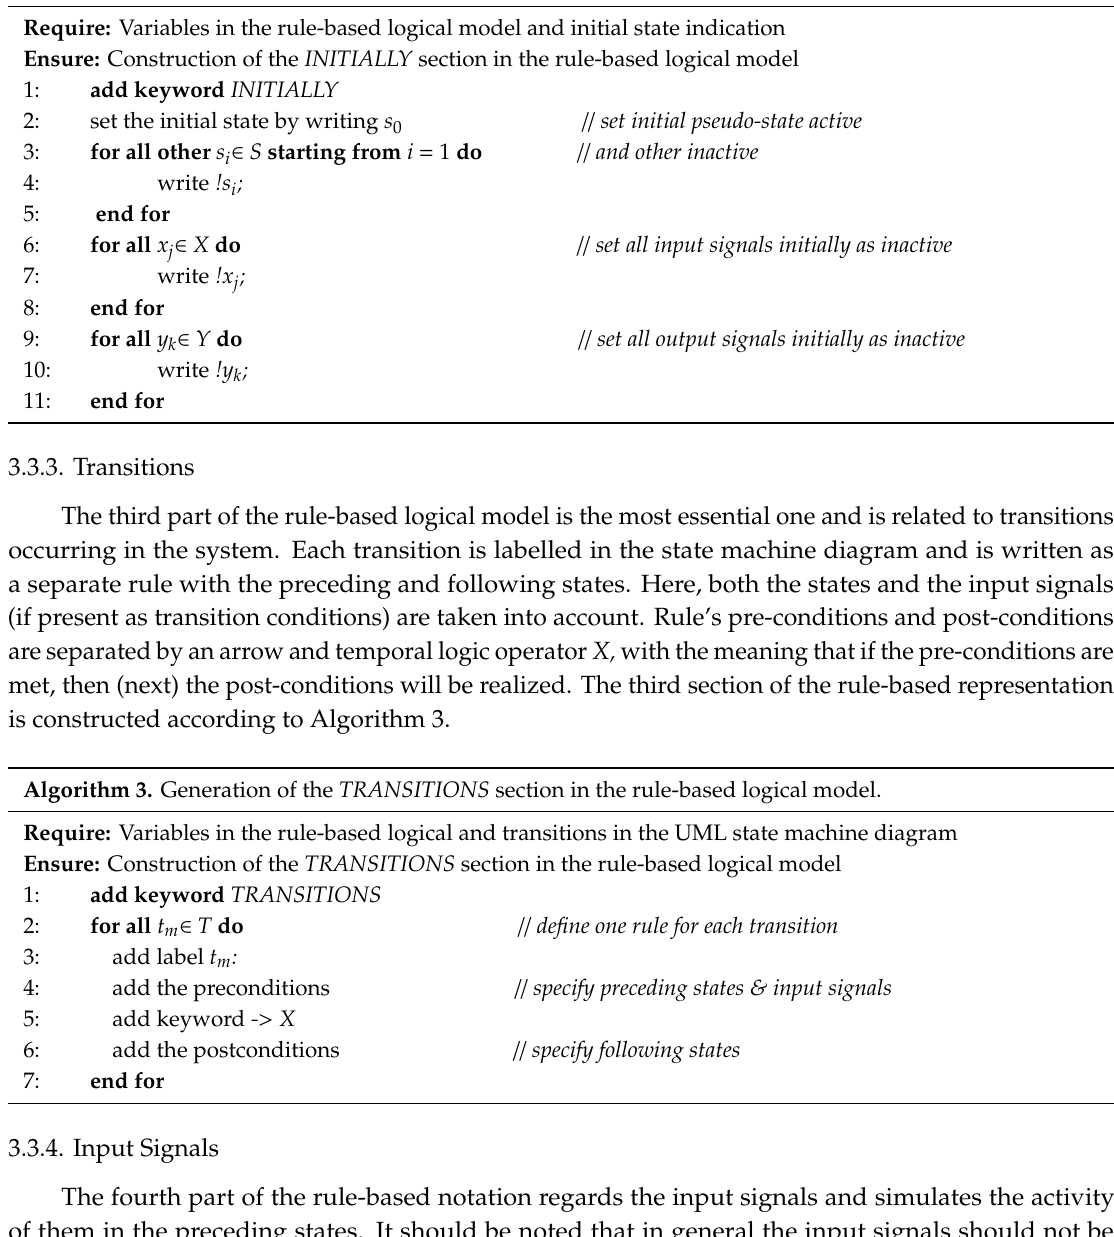
Algorithm 2. Generation of the INITIALLY section in the rule-based logical model.